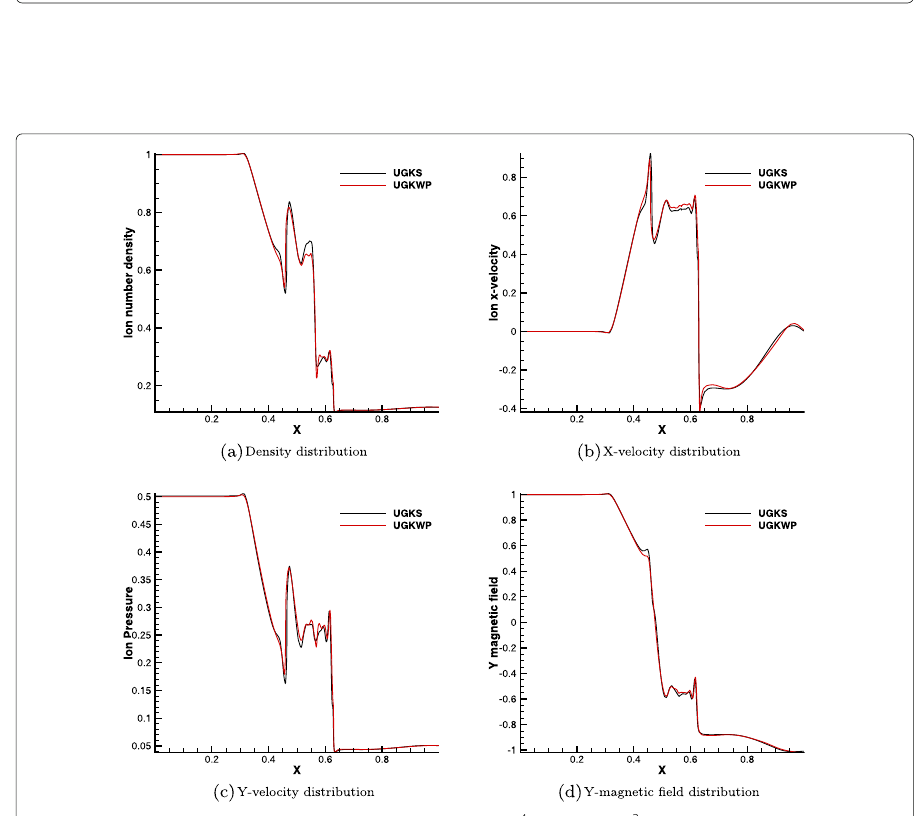
Fig. 10 Multiscale Brio-Wu shock tube problem with Kn=10 4 and r 10 3 . Lines show the UGKWP solutions and symbols show the reference UGKS